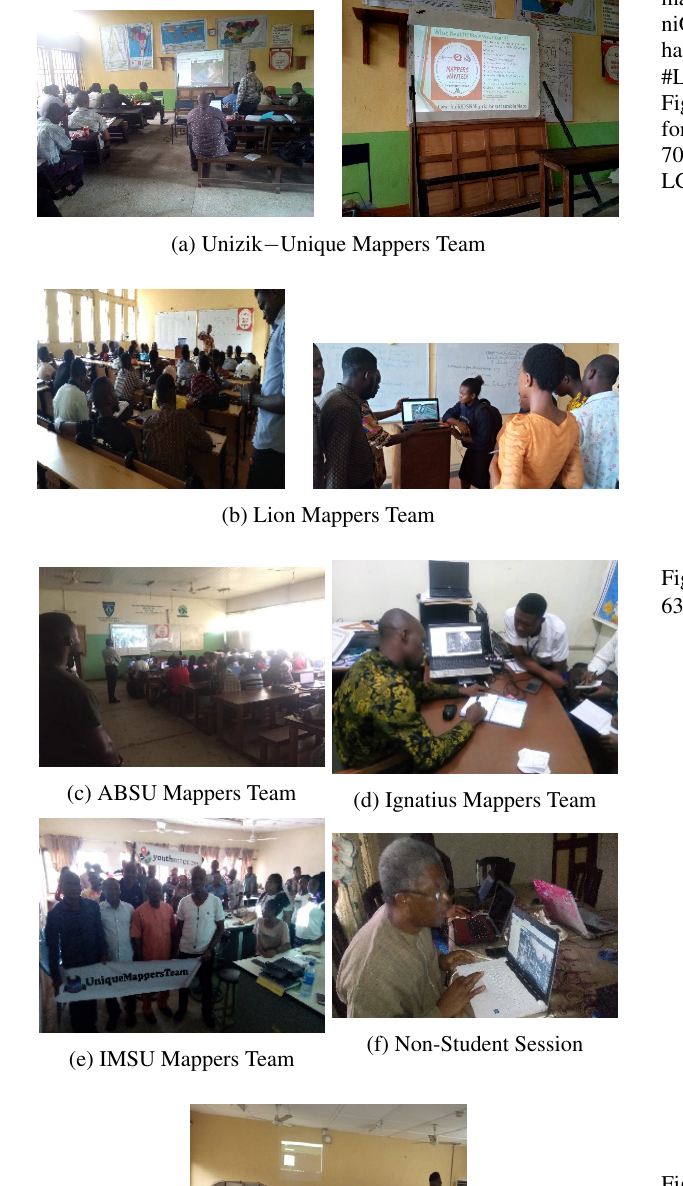
Figure 6: Gokana LGA Delineated HOT Tasking Manager Project